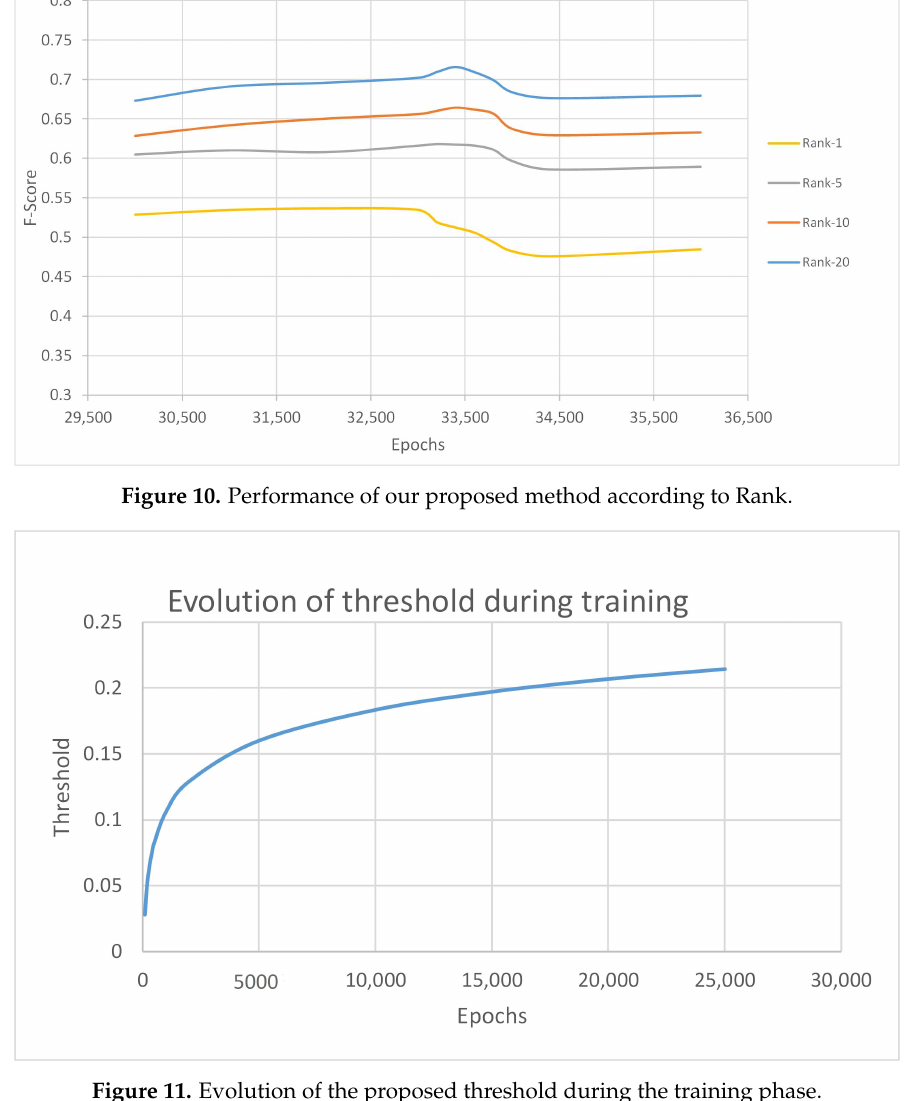
Figure 11. Evolution of the proposed threshold during the training